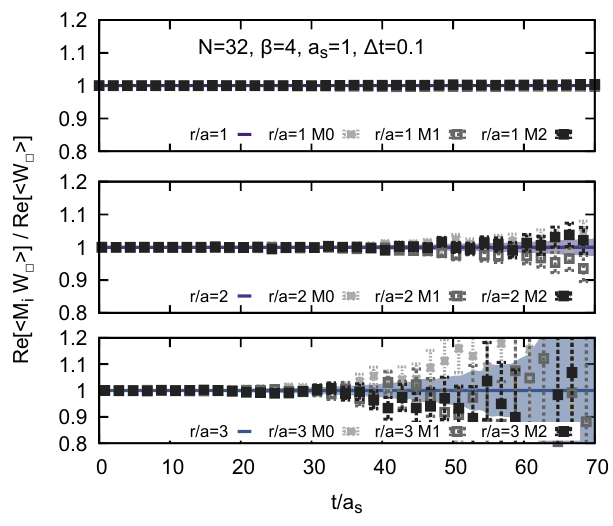
Figure 4 . Comparison of the modified traces of the Wilson loop h M i W i plotted relative to the values of the simple trace h W i evaluated at β = 4 on N x = 32 lattices in the absence of a back- reaction between static sources and the surrounding medium. Very good agreement between the values is